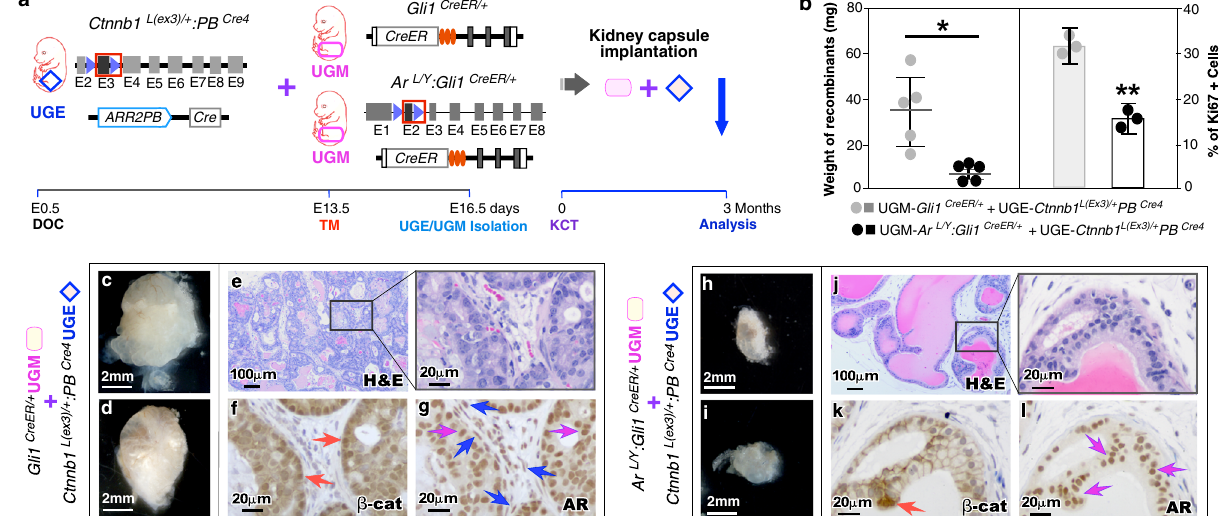
Fig. 1 | Deletion of AR in Gli1-expressing cells in the UGM impairs UGE onco- genic xenograft growth. a Schematic of the experimental timeline for tissue recombination and kidney capsule transplantation. Urogenital sinus epithelium (UGE) from Ctnnb1 L(ex3)/+: PB Cre4 embryos and urogenital sinus mesenchyme (UGM) from Gli1 CreER/+ or Ar L/Y :Gli1 CreER/+ embryosafteractivationof Gli1 CreER/+ arerecombined and grown under the renal capsule of host mice. DOC, day of conception; TM, tamoxifen; KCT, kidney capsule transplantation. b Weights of xenograft recombi- nantsfromtheindicatedUGEandUGMcombinations(leftpanel).Quanti fi cationof the percentage of Ki67 + cells per total cells (right panel). Data are represented as